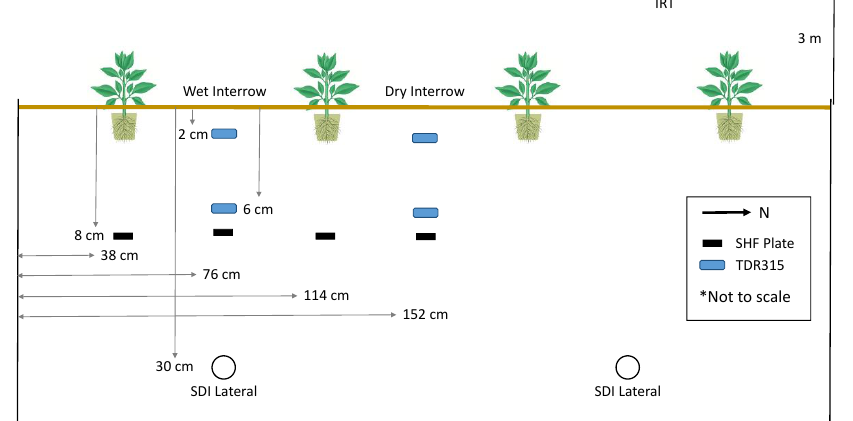
Figure 2. Soil sensor placement within the lysimeter. Shown are relative placement of soil heat flux (SHF) plates, model TDR315 soil water content sensors, and subsurface drip irrigation lines. The TDR315 sensors give accurate soil temperature readings, eliminating the need for thermocouples where they are used.